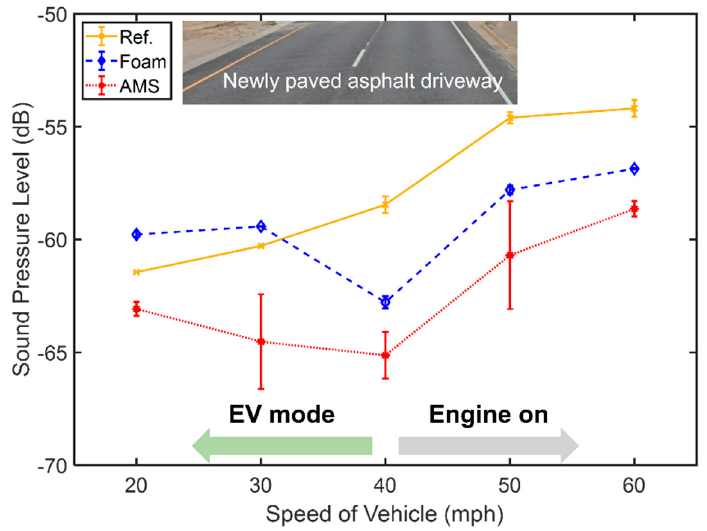
Figure 7. The average sound pressure level from 200 Hz to 300 Hz versus the vehicle’s speed with error bars. Yellow (solid), blue (dashed), and red (dotted) lines represent no attachment, foam attachment, and AMS on the rim, respectively. The inset depicts the newly paved asphalt driveway.